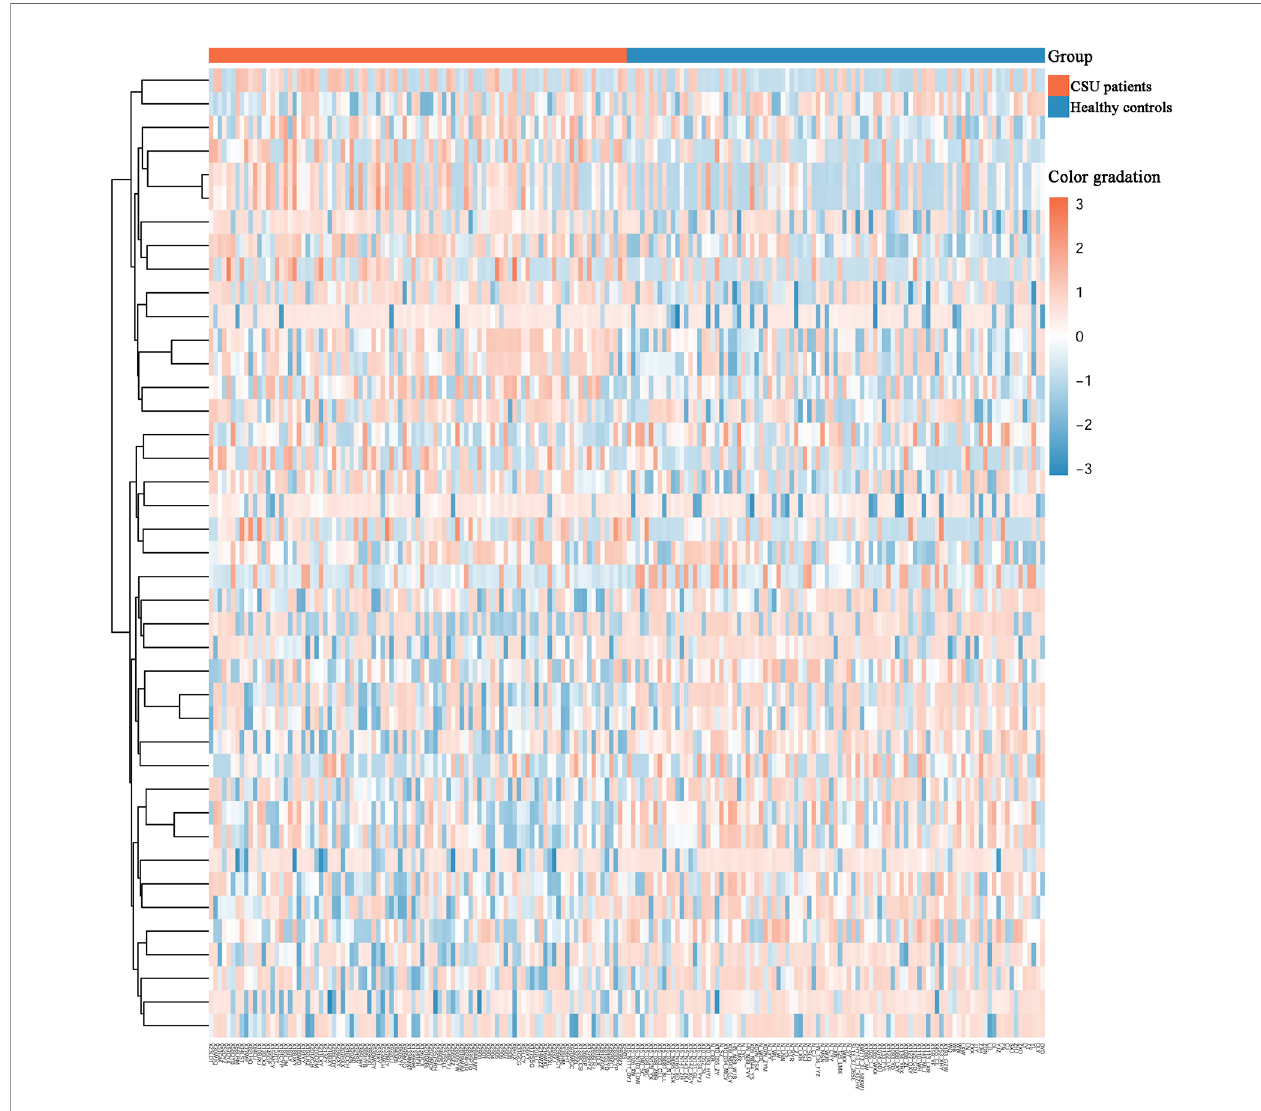
FIGURE 5 | Heatmap of the 41 differentially methylated positions (DMPs) between the CSU patients and the healthy controls ( p < 0.01 and | D b | ≥ 0.1). Two- dimensional hierarchical clustering of the 41 DMPs between the 95 CSU patients and the 95 healthy controls. Each row represents an individual DMP and each column represents a participant. There are 41 rows (41 DMPs) and 190 columns (95 CSU patients vs . 95 healthy controls) in this fi gure. On the top, the CSU patients and the healthy controls are represented by red bars and blue bars, respectively. Color gradation from red to blue means from higher methylation levels to lower methylation level. CSU, chronic spontaneous